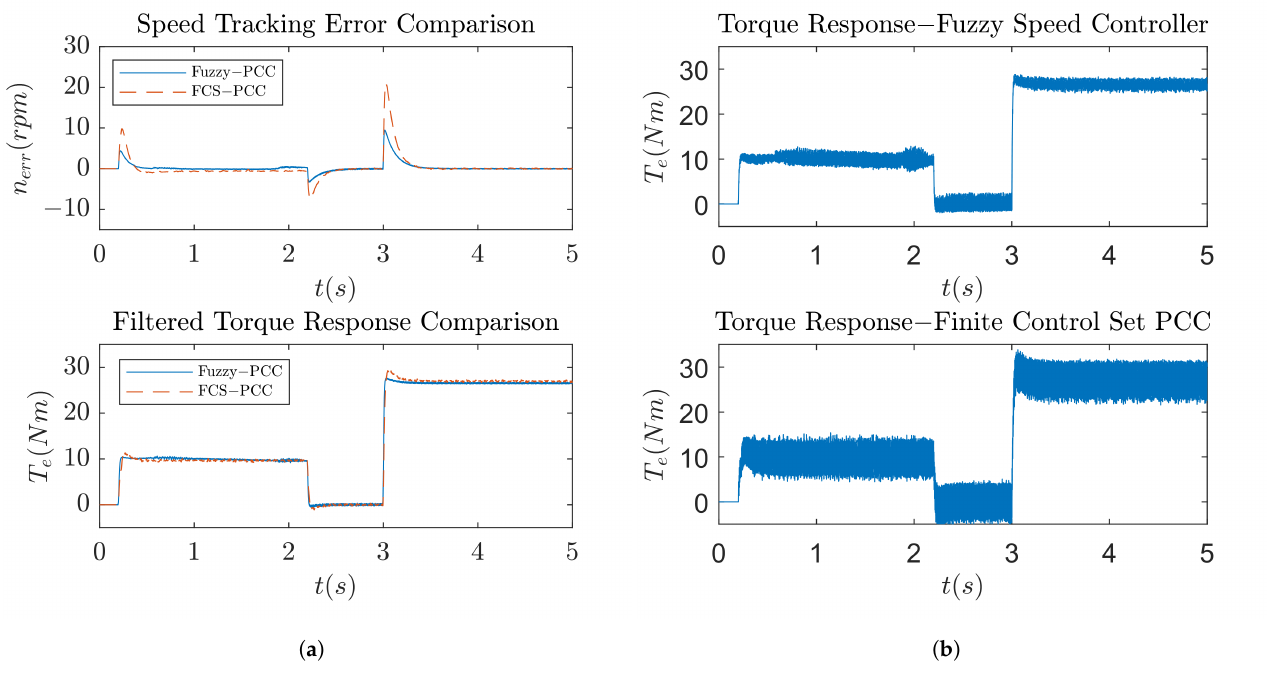
Figure 14. System response comparison between proposed method and FCS-PCC method. ( a ) Speed tracking error and filtered torque response. ( b ) Unfiltered torque response.